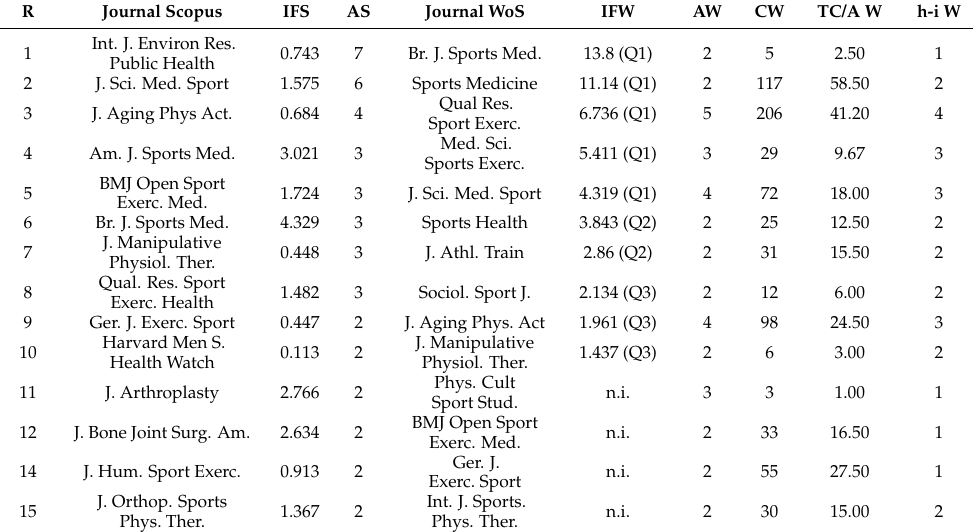
Table 2. Most relevant journals (WoS and